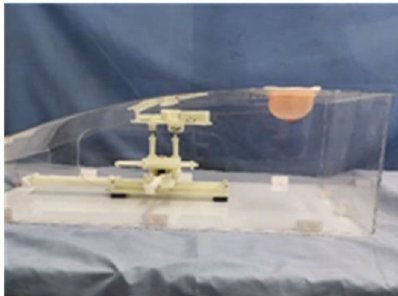
Figure 18: Physical model of breast interventional robot.